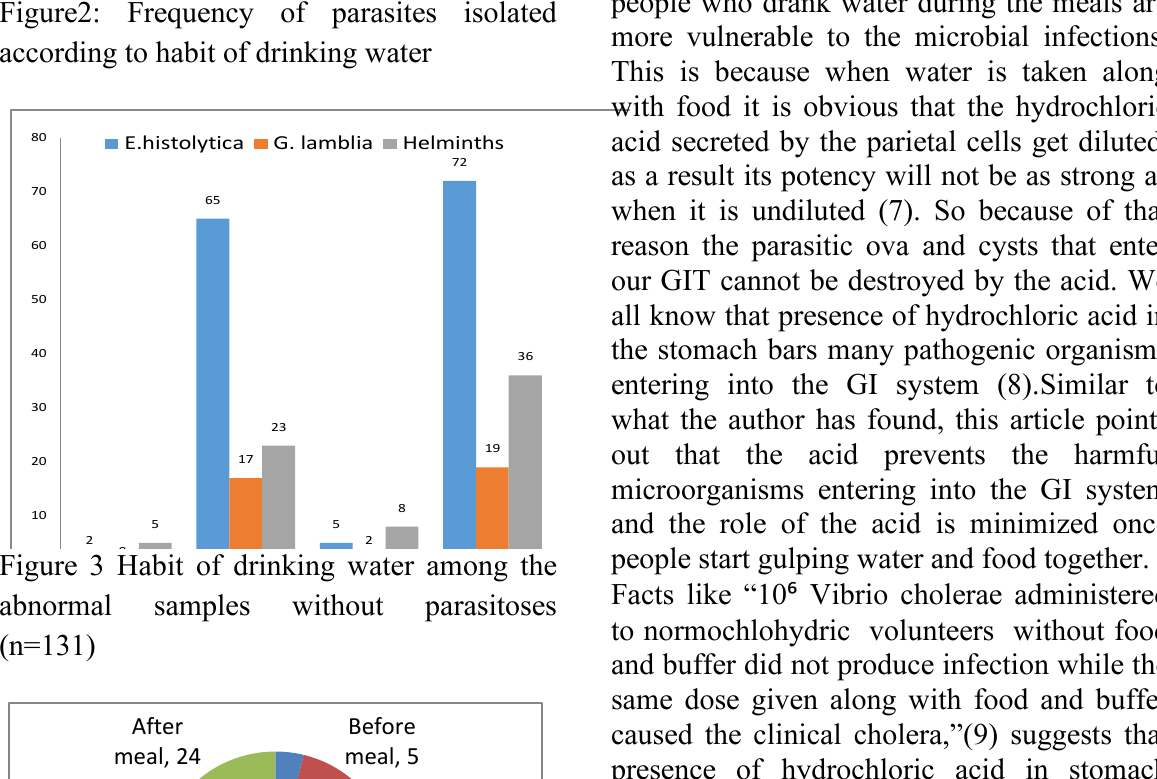
Figure2: Frequency of parasites isolated